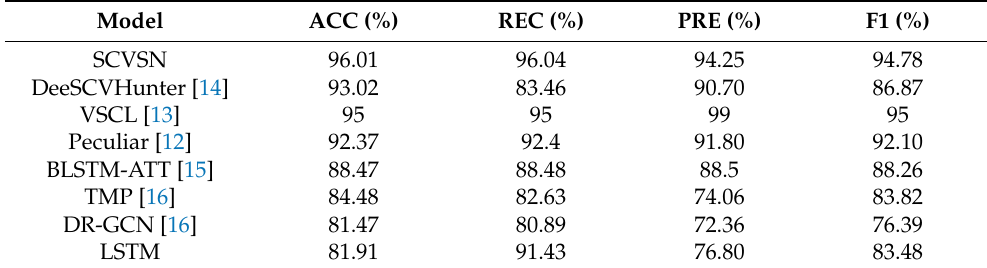
Table 3. Comparison of experimental